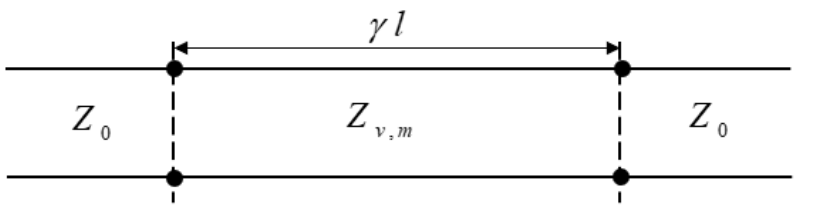
Figure 2. A waveguide of length l , represented by its secondary parameters and the source port’s excited characteristic impedance, Z 0 .